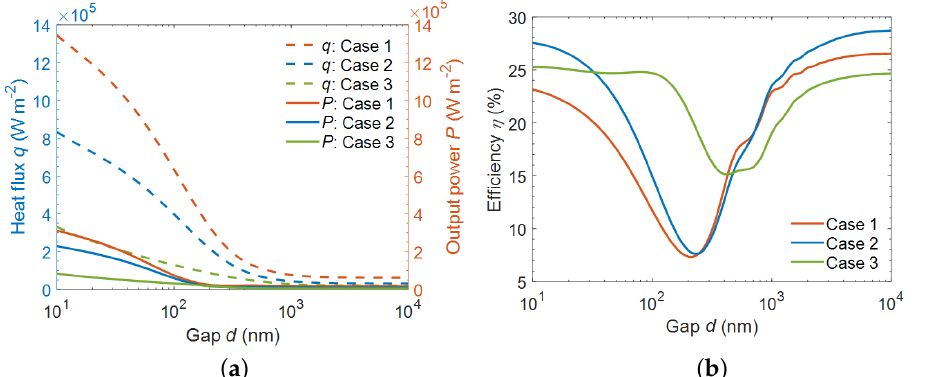
Figure 4. ( a ) Total heat fluxes (dashed lines) and output power (solid lines) as a function of the separation gap. ( b ) Variation in conversion efficiency against the separation gap. These results are based on scenario